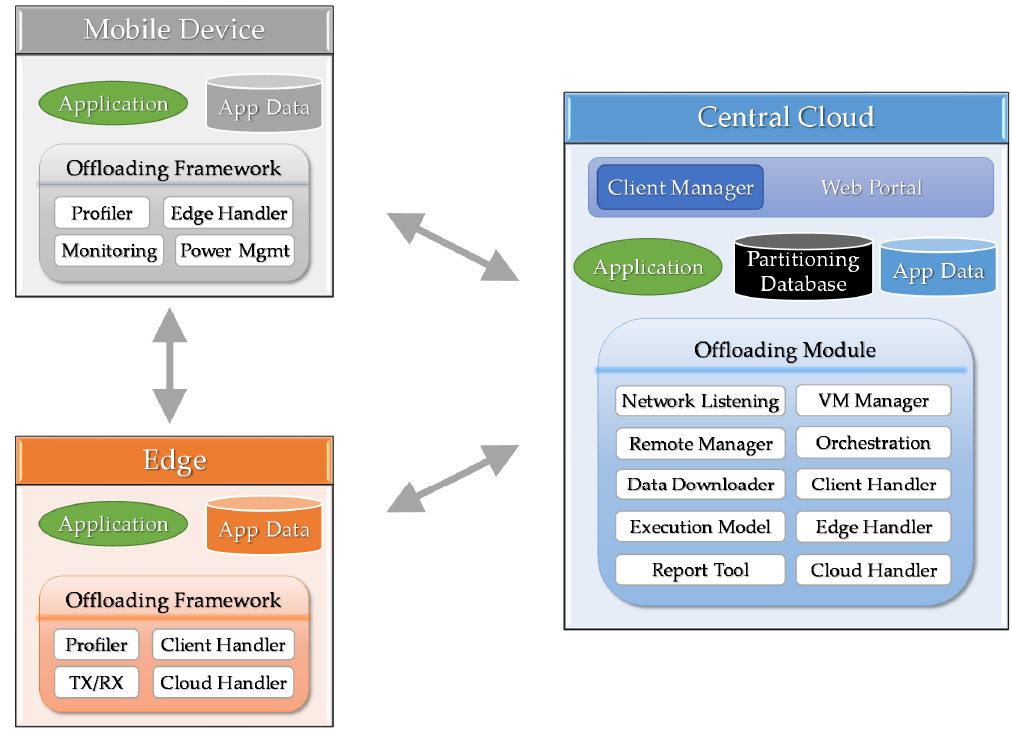
Figure 1. An edge cloud architecture and its interaction.